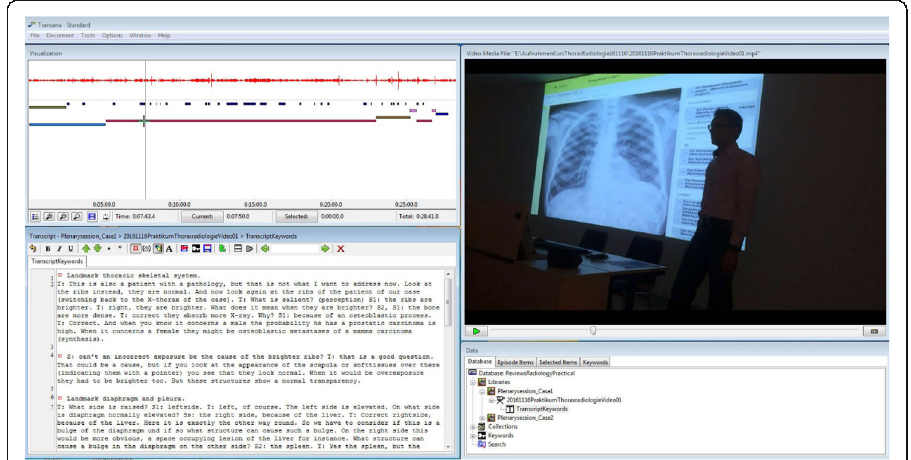
Fig. 6 Interaction analysis of video-recorded, class-wide discussion with Transana. The colored bars in the upper left window depict the different codes assigned to utterances in the discussion. The bottom left window shows the verbatim transcript of the selected segment of the